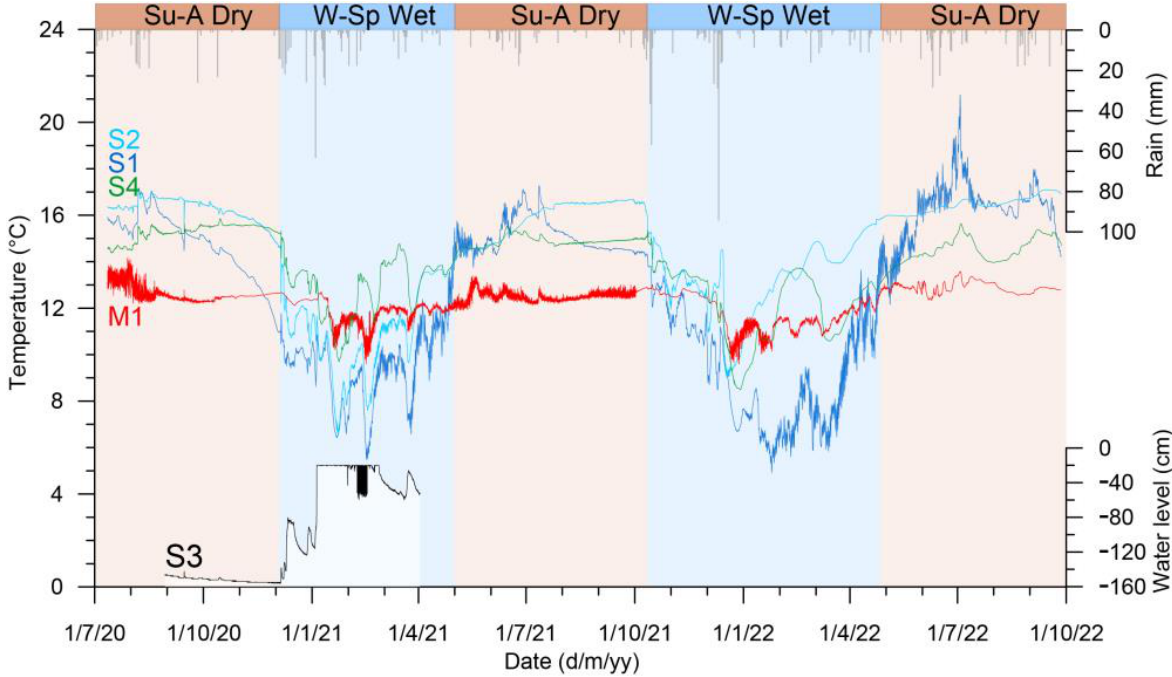
Figure 6. The curves display the discrepancy in the thermal signal between the four main monitoring stations and their relation to flow changes. S2 (light blue) and S4 (green) show the temperature transformation along the main channel of Maaras with a sandy streambed. A significant temperature increase is evident in the late dry season and during flow recession in winter. Sensor S2 was buried in the streambed after the flood in December 2021, thus measuring the hyporheic flow in 2022. Sensor S4 may also have been slightly buried.